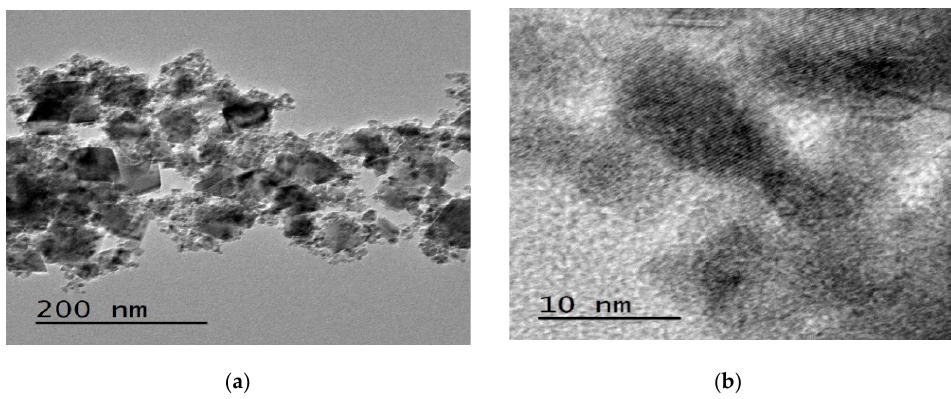
Figure 4 . ( a ) TEM and ( b ) HRTEM images of MnV 0.05 Fe 1.92 O 4 prepared by hydrothermal processing at 180 °C.